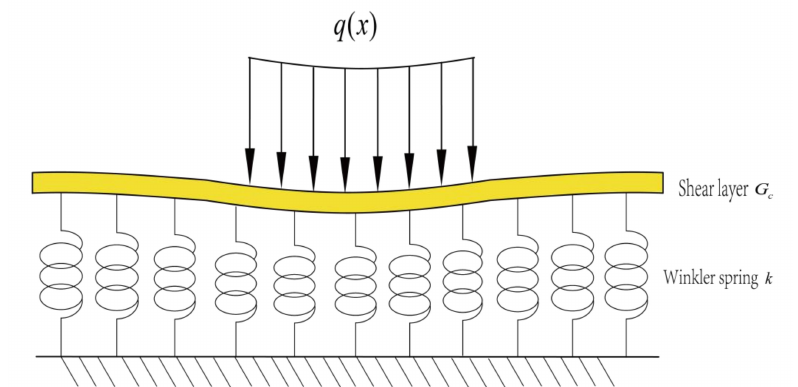
Figure 2. Pasternak foundation model.